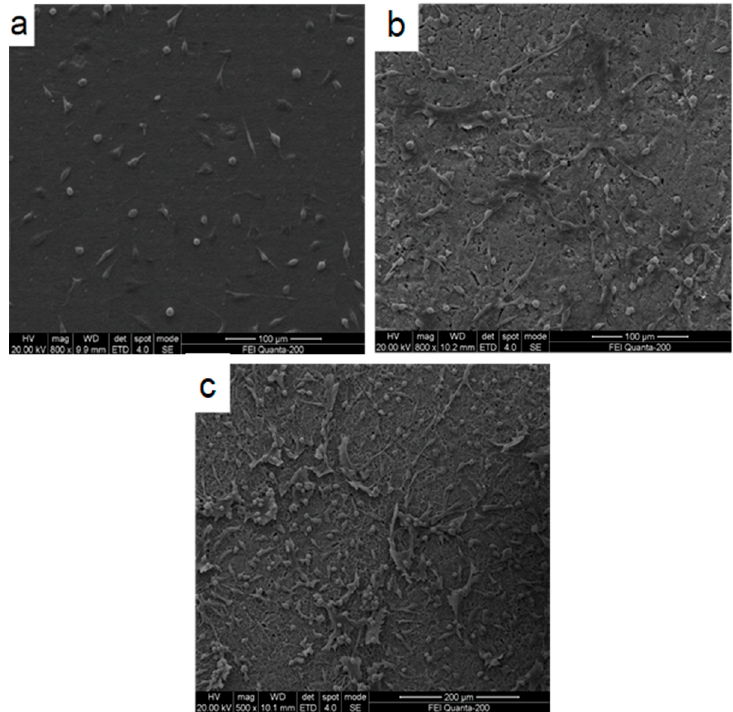
Figure 9. ( a ) SEM image of mesenchymal stem cells grown on uncoated Ti, ( b ) mesenchymal stem cells grown on TiO 2 nanotubes, and ( c ) mesenchymal stem cells grown on HA coated TiO 2 nanotubes.